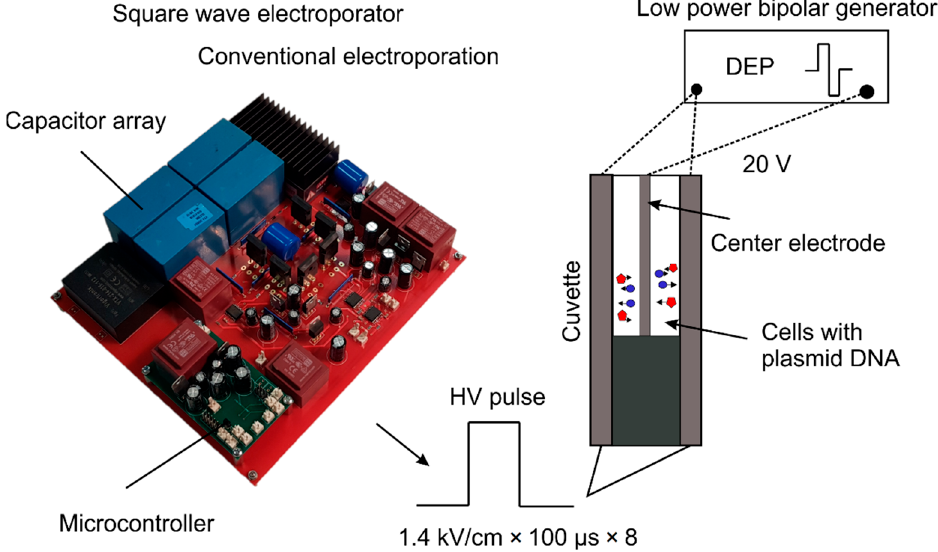
Figure 1. The schematic representation of the dielectrophoresis-assisted electroporation methodol- ogy .